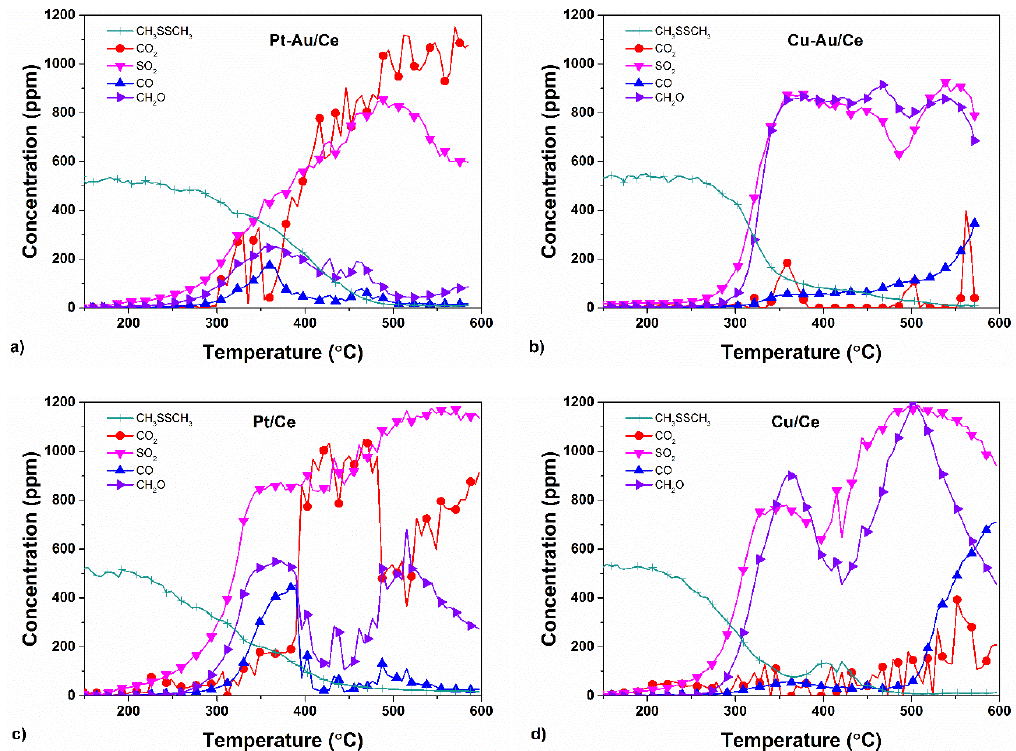
Figure 11. The distribution of the main products, CO 2 , SO 2 , CO, and CH 2 O, with ( a ) Pt–Au on CeO 2 , ( b ) Cu–Au on CeO 2 , ( c ) Pt on CeO 2 and ( d ) Cu on CeO 2 catalysts in the oxidation of DMDS (CH 3 SSCH 3 ). The concentrations of other byproducts were less than 50 ppm (the same experimental conditions as in Figure 9).